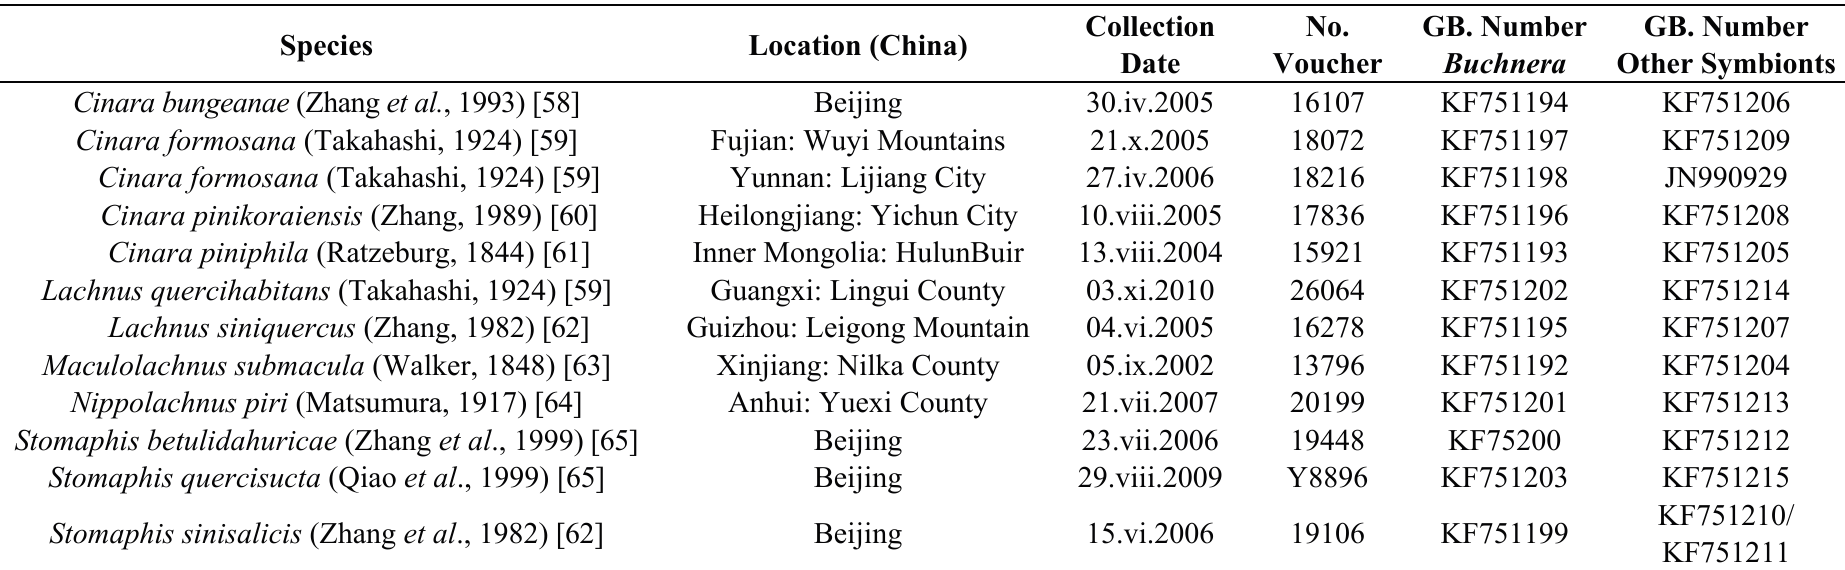
Table 1. The detailed collection information and GenBank accession numbers of endosymbionts of Lachninae